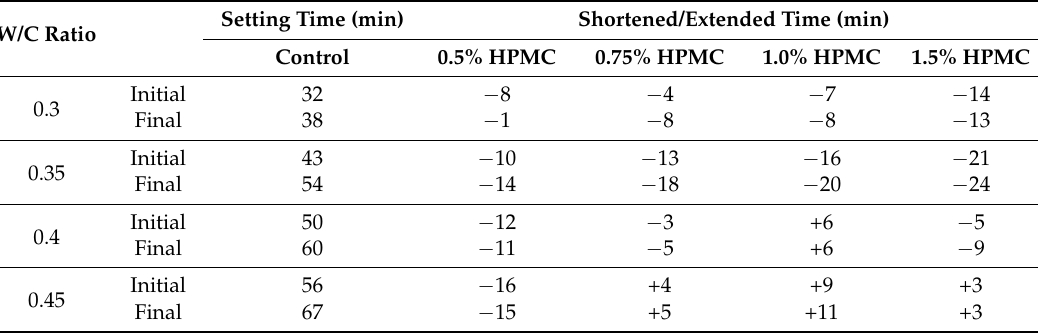
Table 4. Setting time measured using Vicat